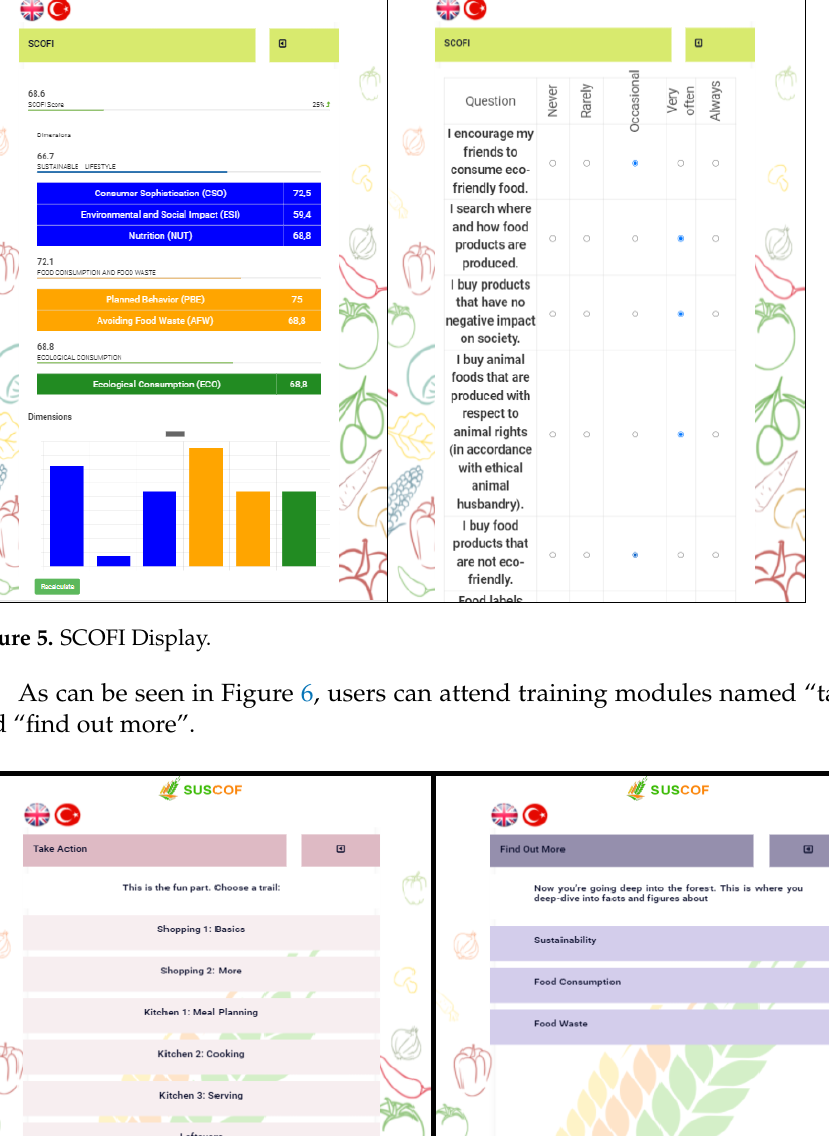
9 of 21 Figure 4. App Home Screen.